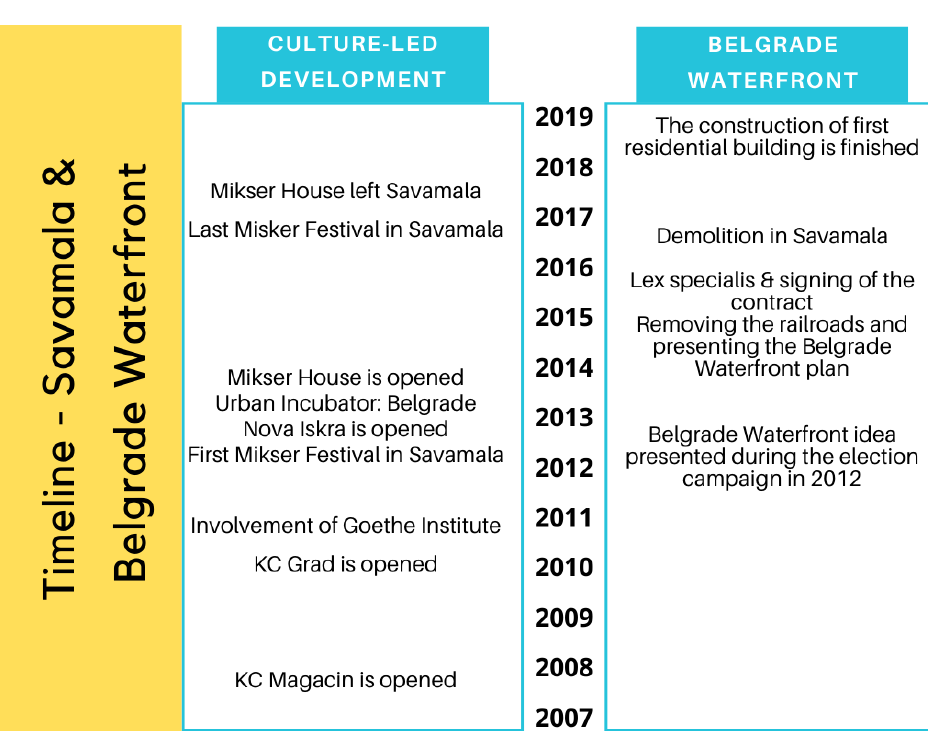
Figure A1. Important buildings and organizations in Savamala.